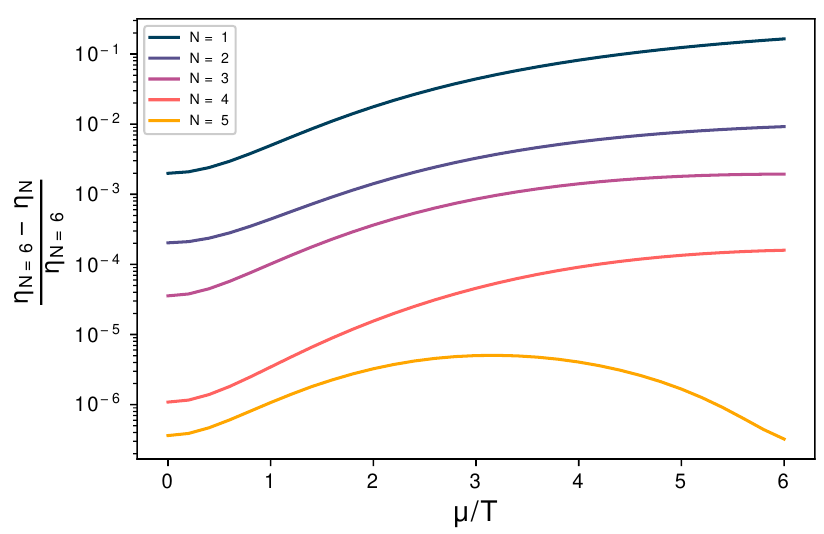
Figure 3 . Basis-size dependence of the extracted shear viscosity. The curves show the relative error for the different basis set sizes when compared to N = 6